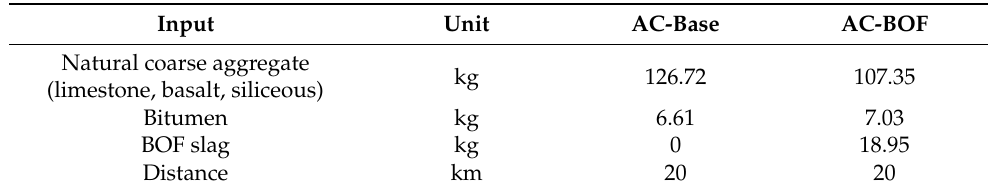
Table 2. The construction materials used in the conventional (AC-Base) and alternative (AC-BOF) scenarios.